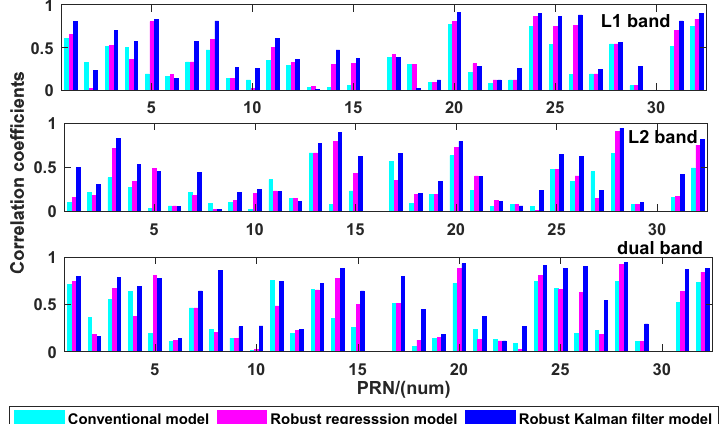
Figure 12. Correlation coefficients of three methods on each frequency with phase.